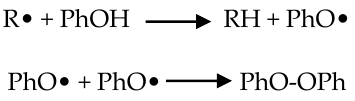
Figure 3. Polyphenolic neutralization of reactive oxygen species (ROS).